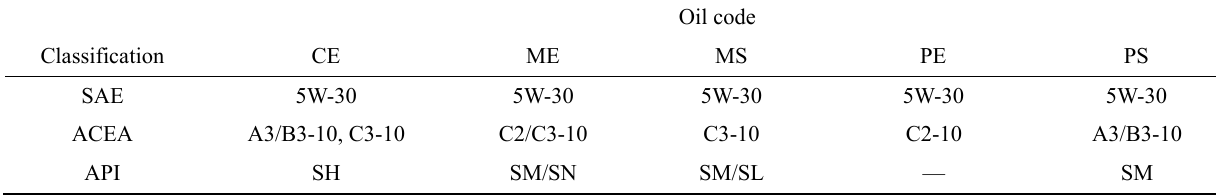
Specifications of the engine oils used in the